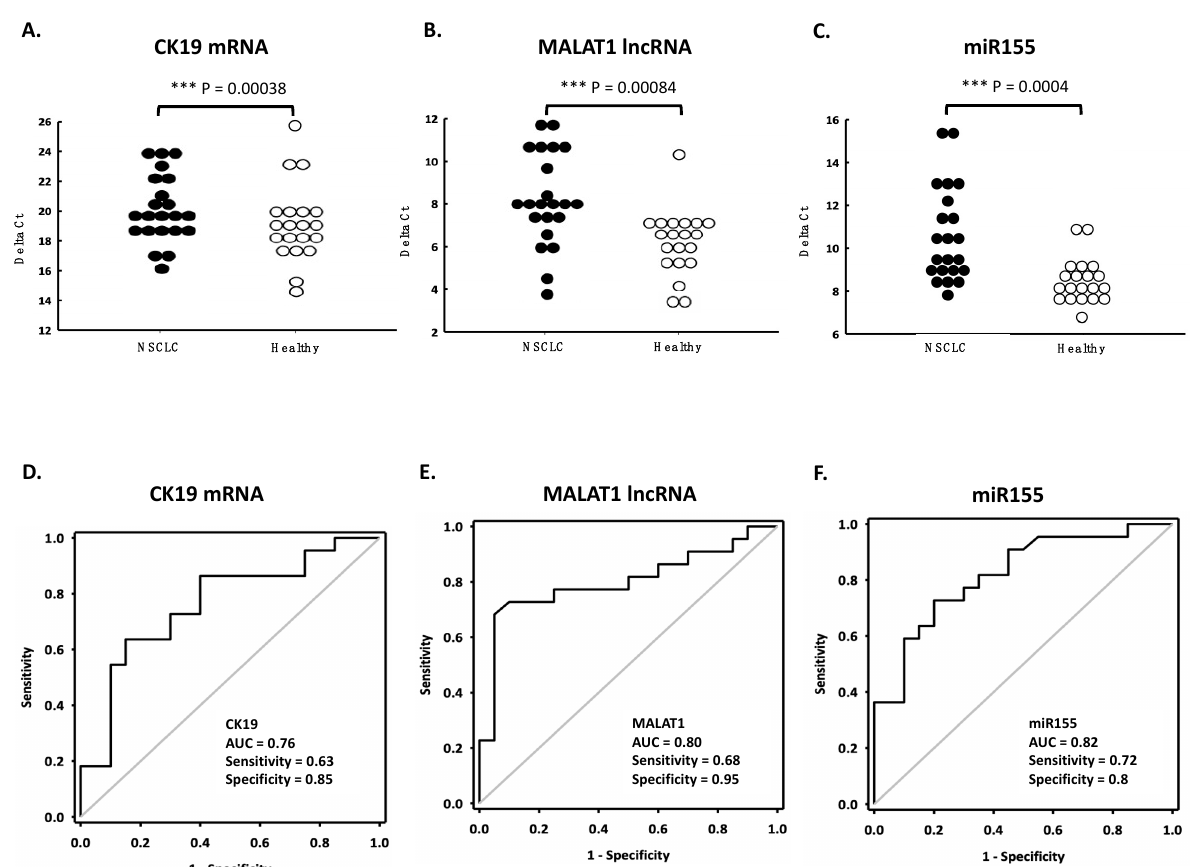
Figure 6. The diagnostic performance of circulating CK19 ( A , D ), MALAT1 ( B , E ) and miR155 ( C , F ) RNA for NSCLC using ANX beads. Plasma samples from NSCLC patients (n = 22) and healthy controls (n = 20) were subjected to RNA purification with ANX beads and RNA quantification with RT-qPCR. The diagram shows the distribution of the RNA levels of different groups ( A – C ) and their receiver operating characteristic curves ( D – F ). *** p <